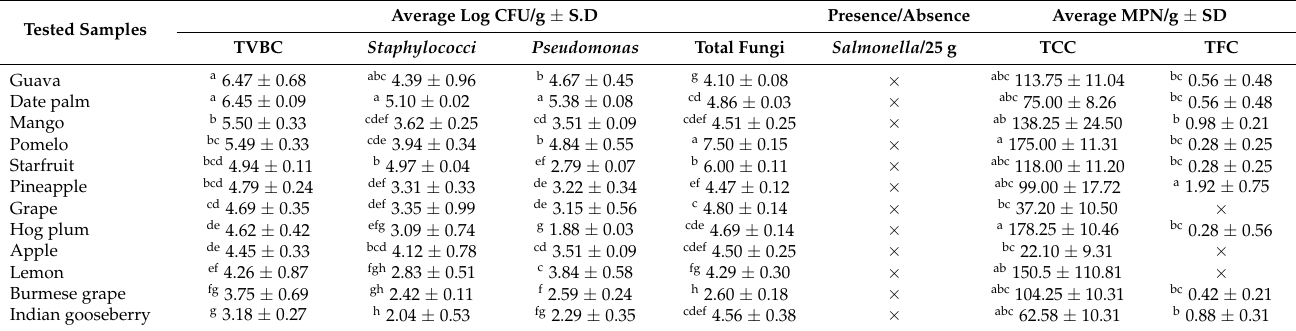
b 0.88 ± 0.31 Mean values followed by different letters within a column of tested samples were found to be significantly different using a post hoc multiple comparisons test ( p < 0.05). MPN = most probable number; CFU = colony-forming unit; TVBC = total viable bacterial count; TCC = total coliform count; TFC = total fecal coliform; “ × ” = not detected. Data are mean ( n = 4) ± standard deviation. On the other hand, the highest and lowest TVBCs were observed at 7.37 ± 0.06 log CFU/g ( V. sinensis ) and 5.67 ± 0.49 log CFU/g ( C. sativus ) on the surface of vegetable samples, respectively (Table 2). Among the fruit samples, the highest number of TCC was found (178.25 ± 10.46 MPN/g) in S. dulcis , and the highest TFC was found (1.92 ± 0.75 MPN/g) in A. comosus (Table 1). TFC was not detected in three samples, namely, apple ( M. pumila ), grape ( V. vinifera ), and lemon ( C. lemon ). On the surface of vegetables, the highest number of TCC was 56.5 ± 37.14 MPN/g in cucumber ( C. sativus ) and the highest number of TFC was 3.78 ± 0.76 MPN/g in teasle gourd ( M. dioica) (Table 1). The presence of TFC was about 100% (40/40) in the vegetable sample and 88.33% (40/48) in the fruit sample (Tables 1 and 2). Table 2. Microbial assessment of fresh vegetables collected from different urban areas in Dhaka City. Average Log CFU/g ± S.D Presence/Absence Average MPN/g ± S.D Samples Pseudomonas